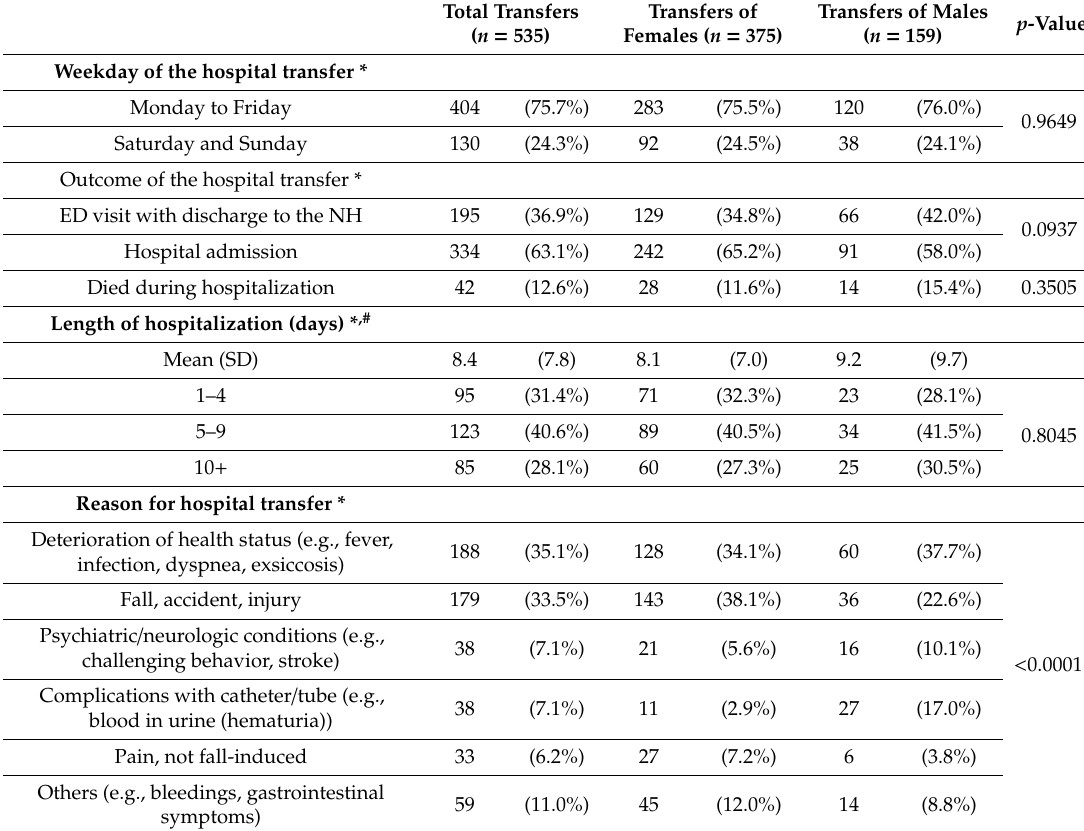
Table 2. Characteristics of unplanned hospital